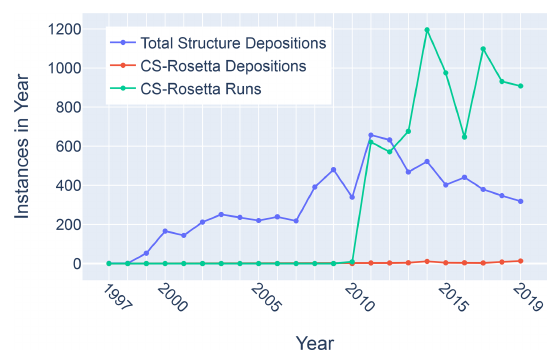
Figure 11. Trends in total BMRB structure depositions (blue), runs executed using the BMRB CS-Rosetta server (green), and deposi- tions citing CS-Rosetta